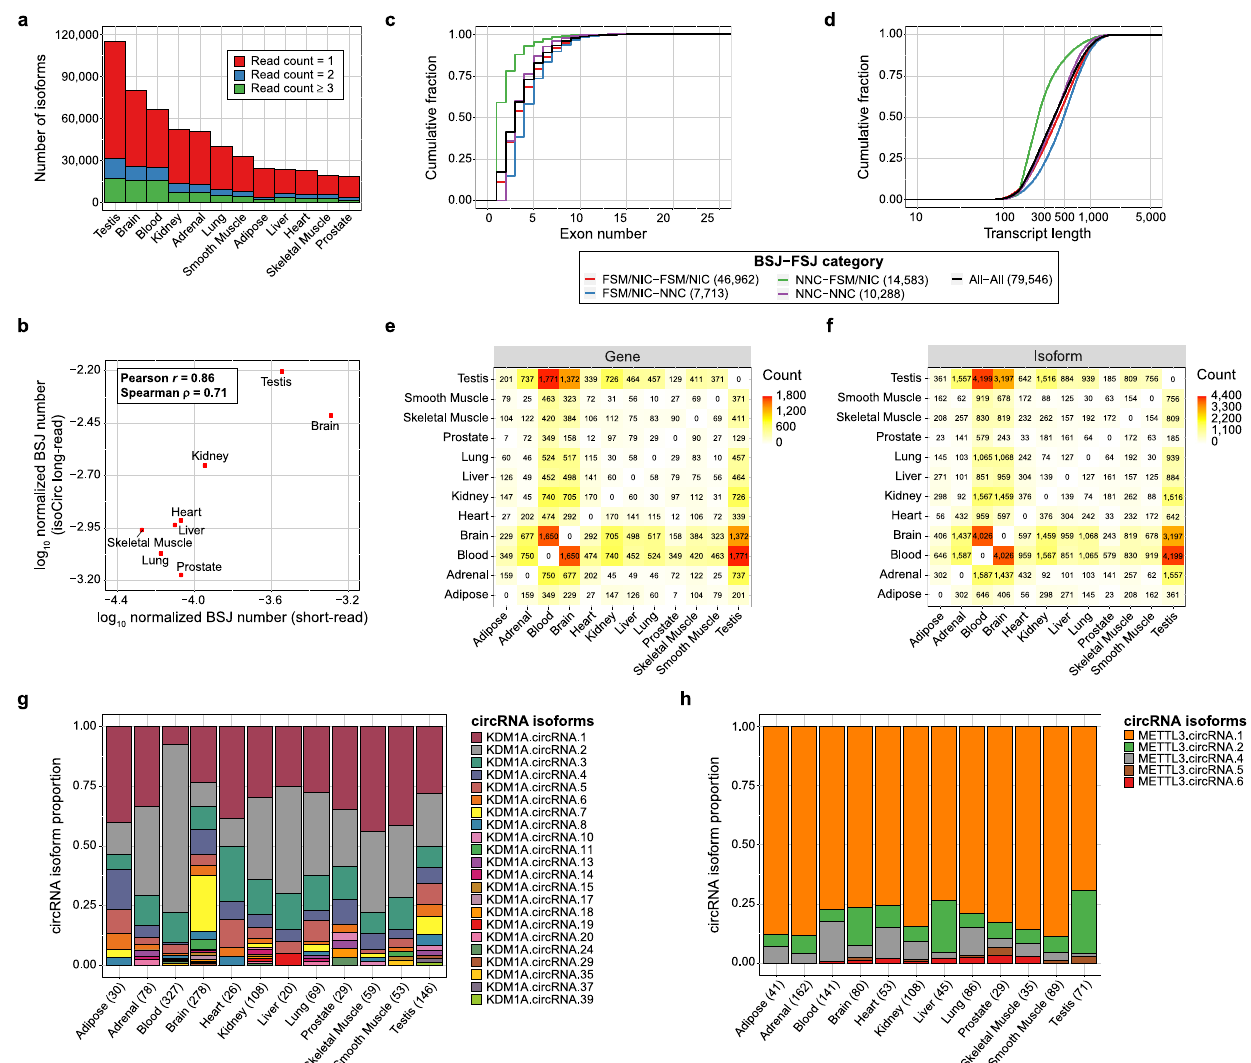
Fig. 3 isoCirc characterization of circRNAs in 12 human tissues. a Barplot showing number of full-length circRNA isoforms ( y -axis) identi fi ed in each of 12 human tissues ( x -axis), for read count = 1 (red), read count = 2 (blue), or read count ≥ 3 (green). b Correlation of number of circRNA BSJs identi fi ed from eight human tissues in published short-read datasets 17 and isoCirc long-read datasets. For each tissue, number of unique circRNA BSJs identi fi ed in either short-read ( x -axis) or long-read ( y -axis) data was normalized by the total number of short reads or long reads in that tissue. Data were plotted as log 10 transformed for ease of comparison and visualization. c Cumulative distribution plot of exon number per isoform for full-length circRNA isoforms with read count ≥ 2 in at least one of 12 human tissues. Isoforms were classi fi ed by their BSJ-FSJ categories, as follows: both BSJ and FSJs were FSM or NIC (red: FSM/NIC-FSM/NIC); BSJ was FSM or NIC, FSJs were NNC (blue: FSM/NIC-NNC); BSJ was NNC, FSJs were FSM or NIC (green: NNC-FSM/NIC); both BSJ and FSJs were NNC (purple: NNC – NNC); and all isoforms were combined (black: All – All). d Cumulative distribution plot of transcript length (nt) for full- length circRNA isoforms with read count ≥ 2 in at least one of 12 human tissues. Isoforms were classi fi ed by their BSJ-FSJ categories, as described in ( c ). e Heatmap showing numbers of genes with differential proportions of circRNA isoforms between each pair of 12 human tissues. f Heatmap showing numbers of circRNA isoforms with differential isoform proportions between each pair of 12 human tissues. g Stacked barplot showing isoform proportions of KDM1A circRNA isoforms across 12 human tissues. CircRNA isoforms were included in plot if read count was ≥ 2 in at least one tissue, and both BSJ and FSJs were FSM or NIC (FSM/NIC-FSM/NIC). Total read count for all circRNA isoforms in a tissue is given in parentheses on x -axis. h Stacked barplot showing isoform proportions of METTL3 circRNA isoforms across 12 human tissues. Details are as in ( g